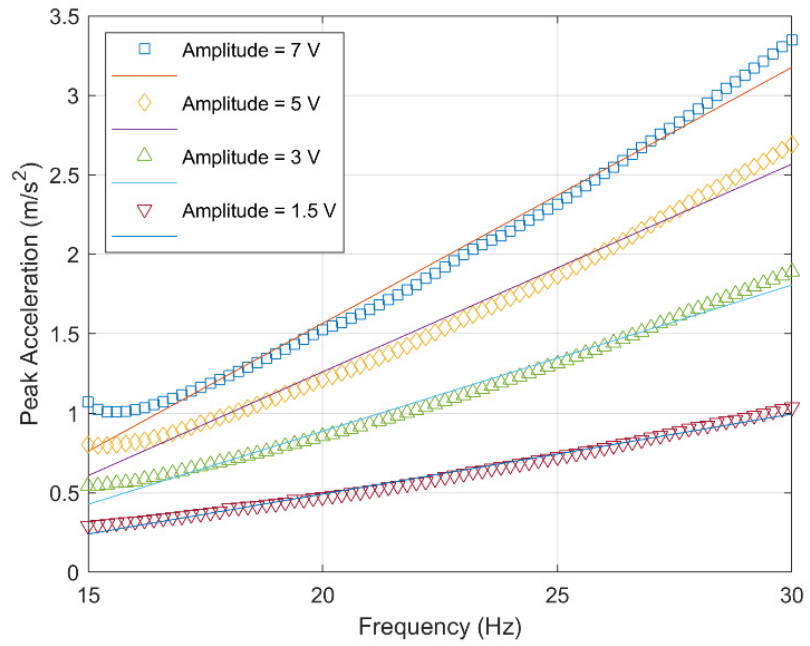
Figure 5. The frequency–acceleration response to the excitation of the resonant vibration speaker in the range of 15–30 Hz for several values of the sinusoidal wave amplitude.